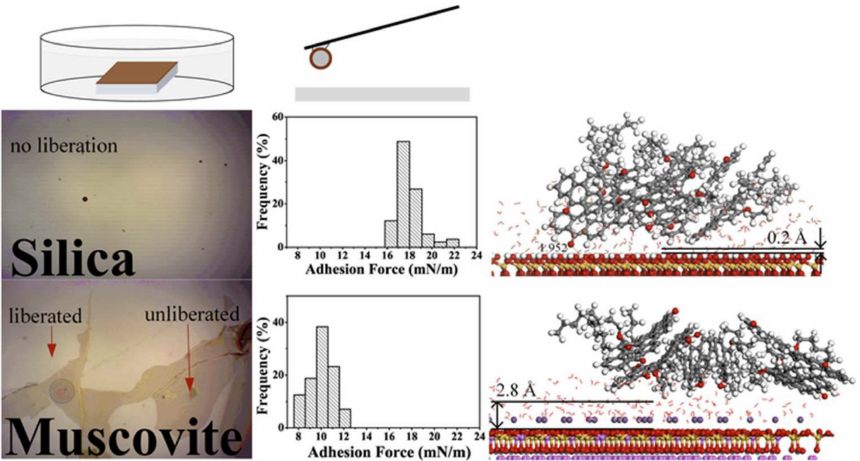
Figure 22. The liberation mechanism of asphaltenes on muscovite surface. Reprinted with permission from Ref. [198]. Copyright 2017, copyright the American Chemical Society. More details on Copyright and Liscensing are available via the following link: https://pubs.acs.org/.